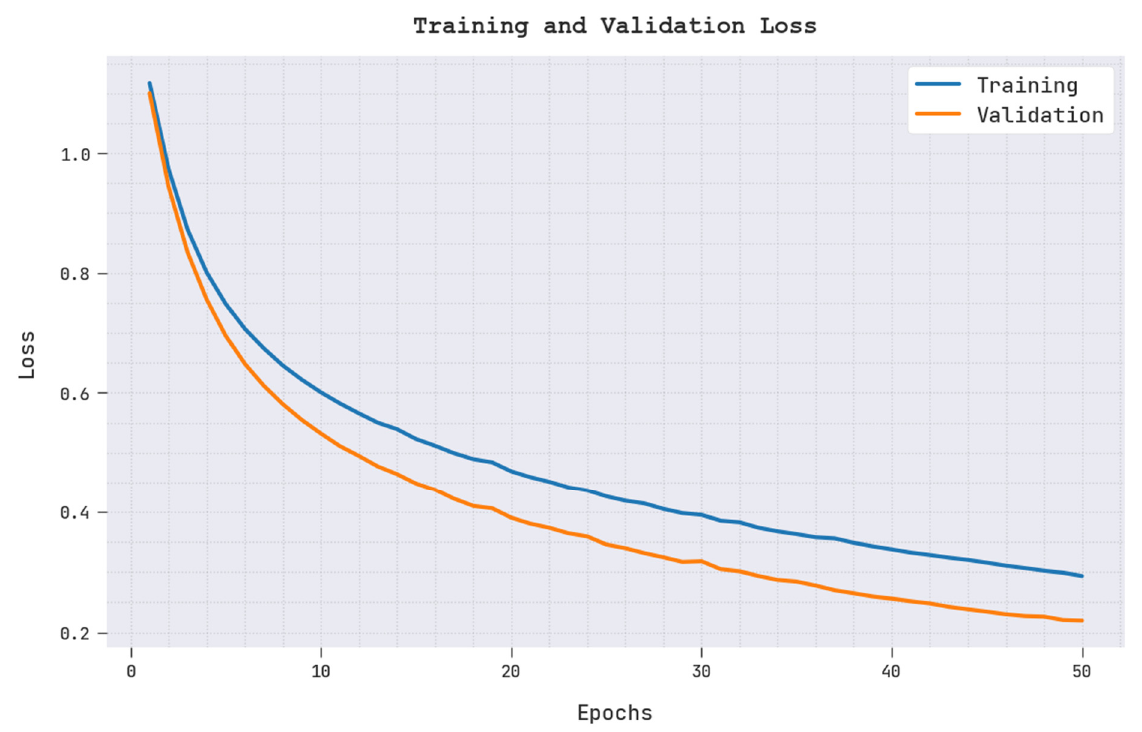
Figure 7. TR acc and VL acc analysis of the AOTL-CDA3S system.